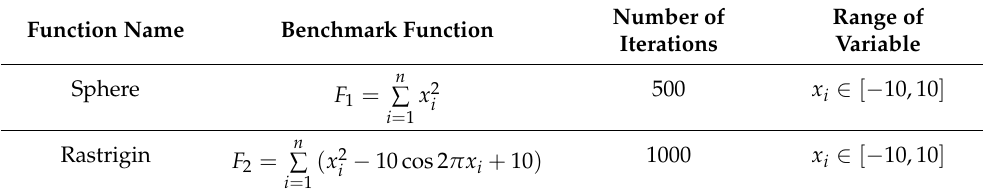
Figure 5. Image s of two-dimensional ( a ) Sphere and ( b ) Rastrigin functions when n = 2. Figure 5. Images of two-dimensional ( a ) Sphere and ( b ) Rastrigin functions when n = 2. Table 1. Benchmark function